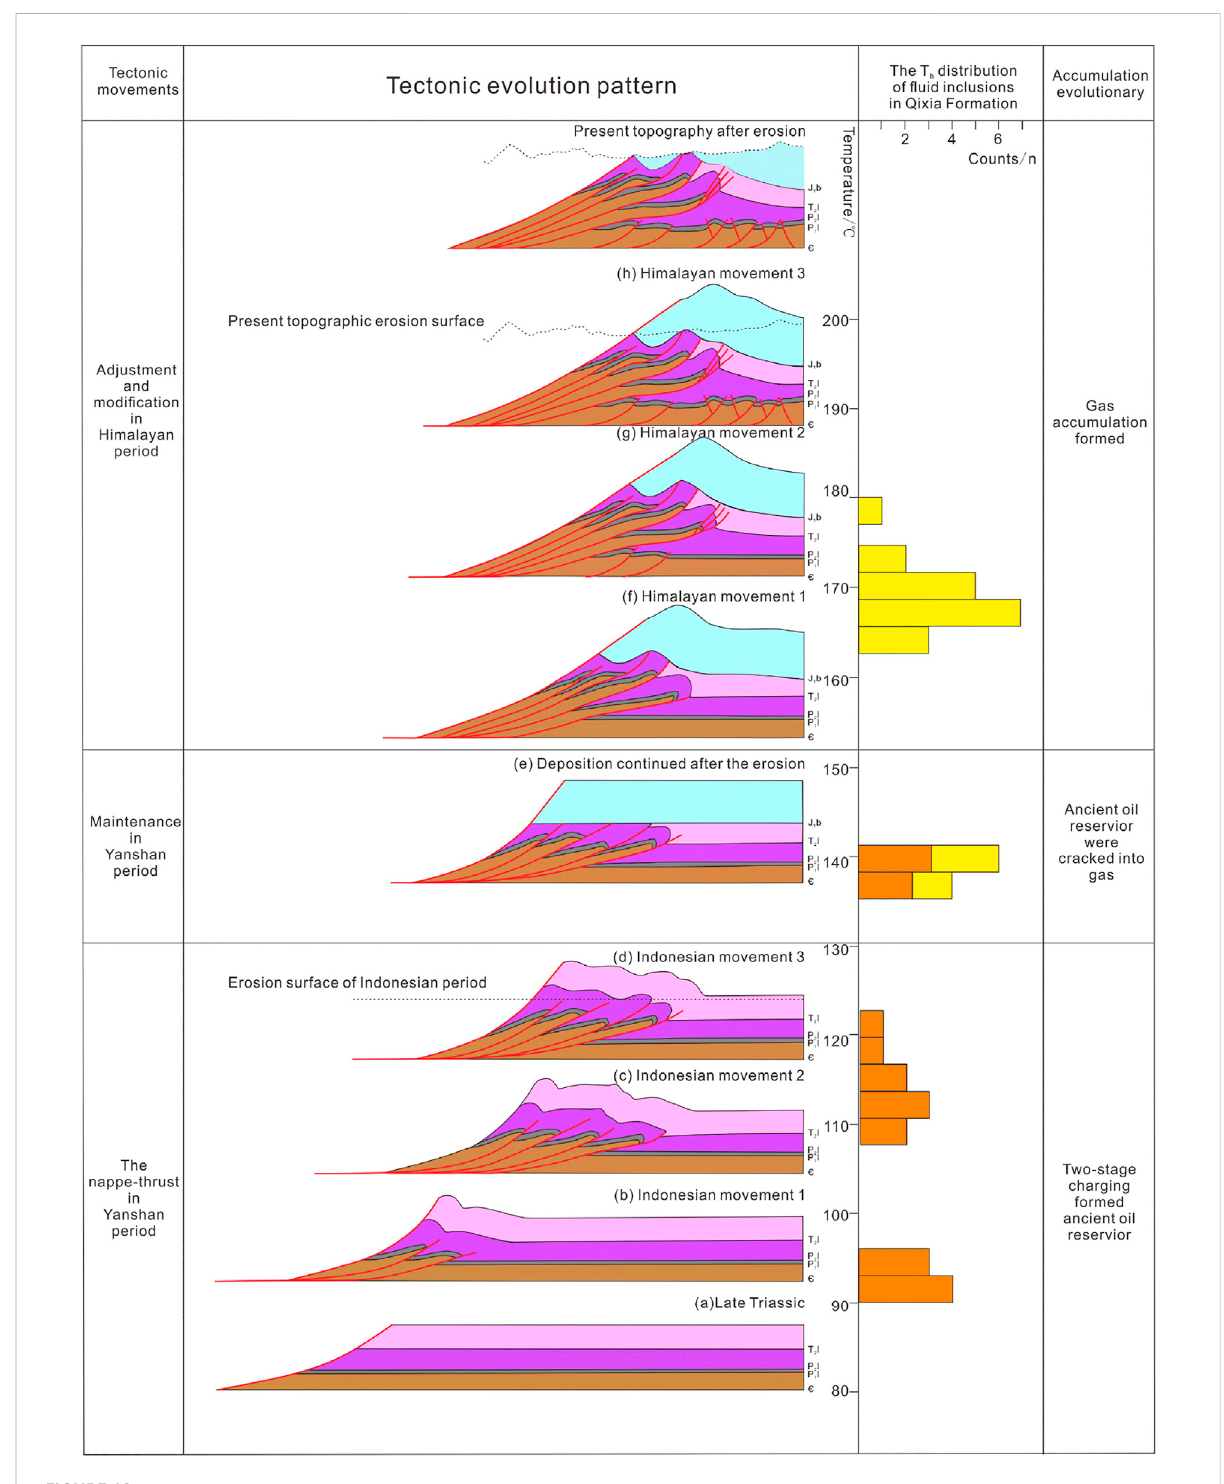
FIGURE 12 Matching relationship between hydrocarbon charging and palaeo-structural evolution of the Qixia Formation in Sichuan shows patterns of oil and gas charging and structural recovery.